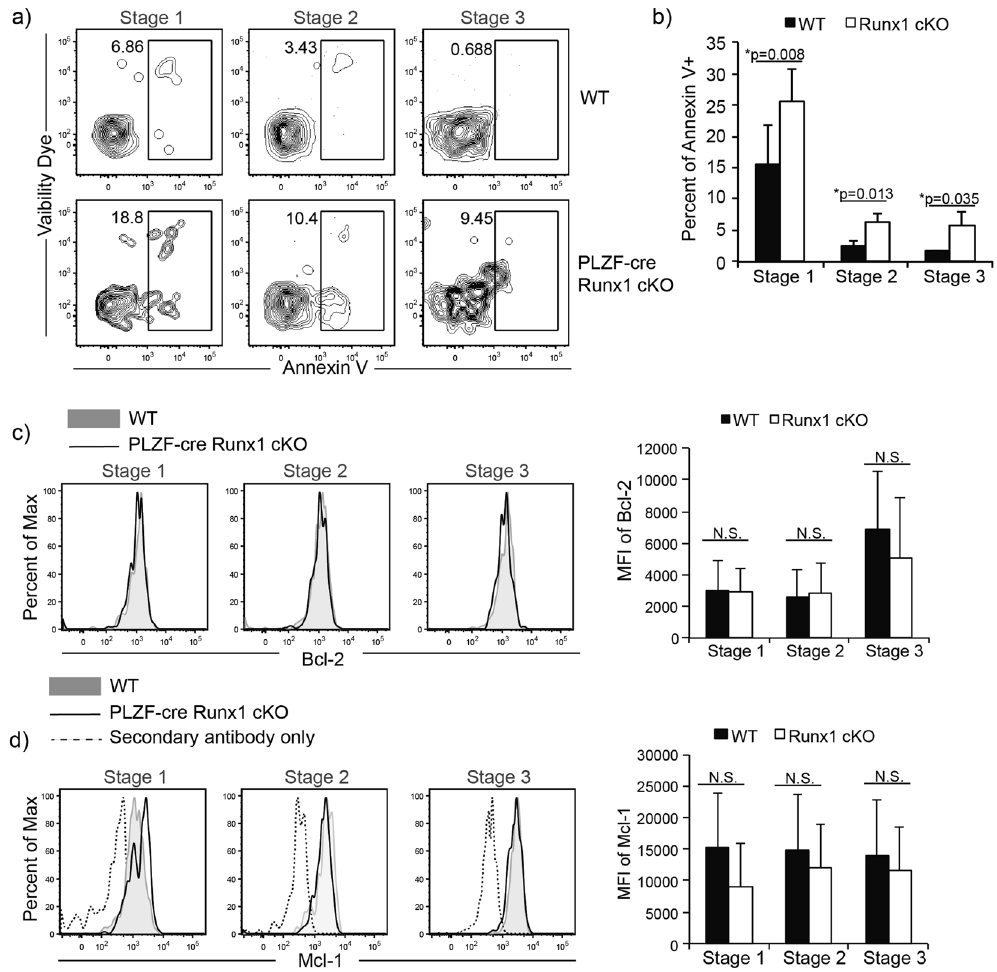
Figure 3. Runx1-deficient iNKT cells exhibit increased apoptosis but normal expression of pro-survival genes Bcl-2 and Mcl-1. ( a ) Representative frequency of apoptotic (Annexin V + ) Stage 1–3 iNKT cells in WT (top) and PLZF-cre Runx1 cKO mice (bottom). Gating for iNKT cells and their developmental stages were defined as described in Fig. 1. Data is representative of at least 7 mice/genotype from 5 different experiments. ( b ) Quantification of apoptotic Stage 1–3 iNKT cells in WT (black bars) and PLZF-cre Runx1 cKO mice (white bars). Data was calculated from at least 7 mice/genotype from 5 different experiments. ( c ) Intracellular expression of pro-survival gene Bcl-2 in Stage 1–3 iNKT cells from WT (grey filled) and PLZF-cre Hdac3 cKO (black line). Data is representative of at least 3 mice/genotype from 3 different experiments. Quantification of MFI of Bcl-2 in Stage 1–3 iNKT cells in WT (black bars) and PLZF-cre Runx1 cKO mice (white bars). Data was calculated from 3 mice/genotype. ( d ) Intracellular expression of pro-survival gene Mcl-1 in Stage 1-3 iNKT cells from WT (grey filled) and PLZF-cre Hdac3 cKO (black line). Secondary only control for Mcl-1 is shown as dashed line. Data is representative of at least 3 mice/genotype from 3 different experiments. Quantification of MFI of Mcl-1 in Stage 1-3 iNKT cells in WT (black bars) and PLZF-cre Runx1 cKO mice (white bars). Data was calculated from 5 WT and 3 PLZF-cre Runx1 cKO mice. All statistical analysis was done using Student’s t-test . Means ±